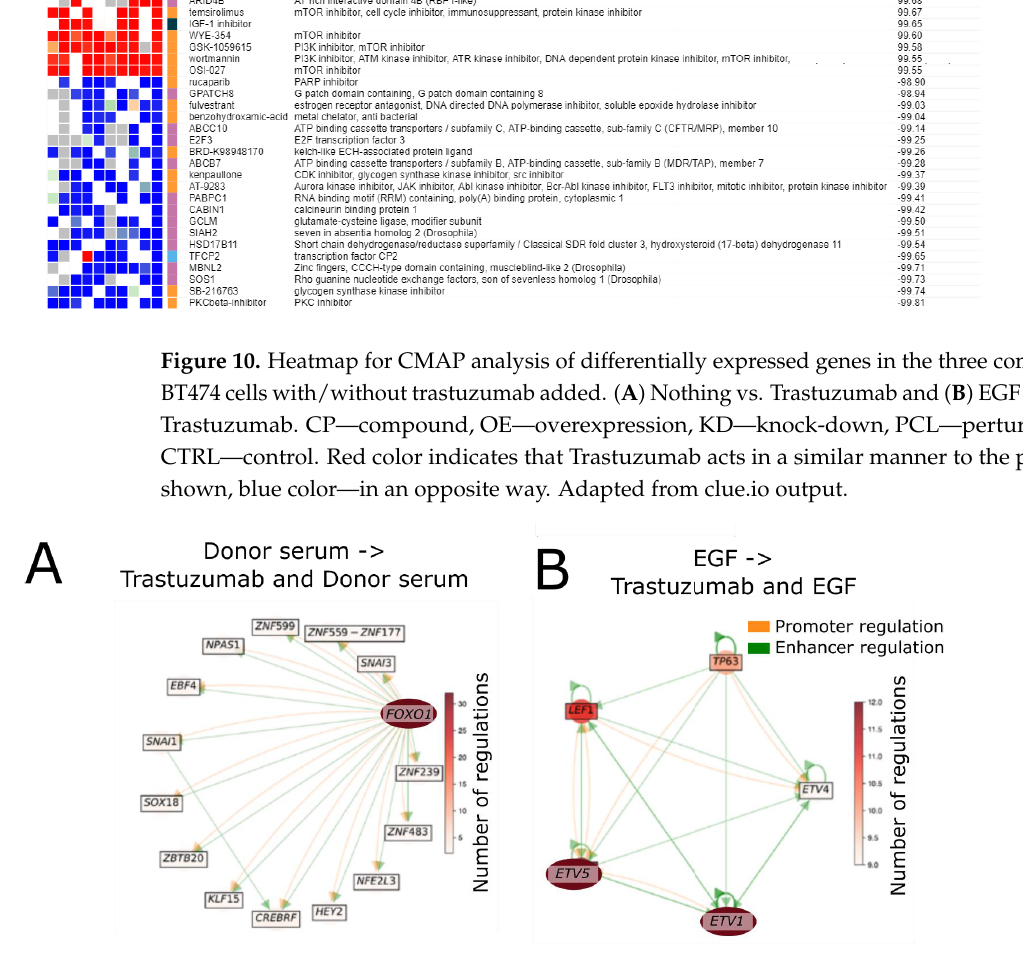
Figure 11. Gene-regulatory network analysis for ( A ) Donor serum to Trastuzumab and donor serum condition; ( B ) EGF to EGF and Trastuzumab condition. Promoter regulation is shown in orange, enhancer regulation — in green. Node color depth indicates the number of regulatory interactions (see color scale). (see color